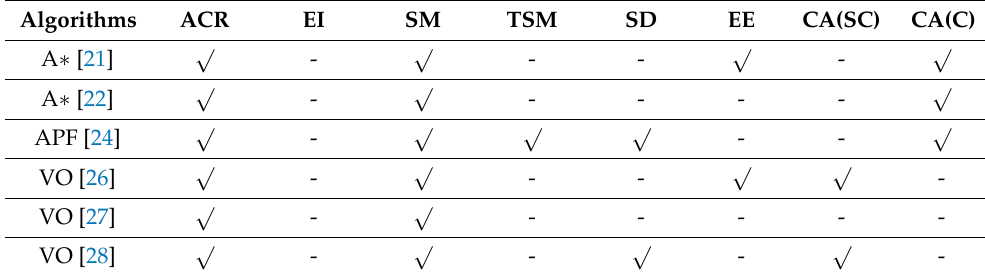
Table 12. Method of requirements specifications.